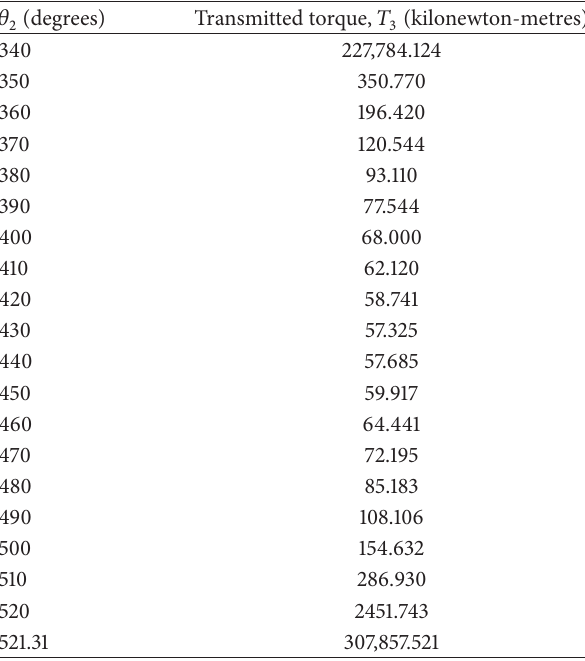
Table 3: Sample values of the transmitted torque during the crush- ing stroke.